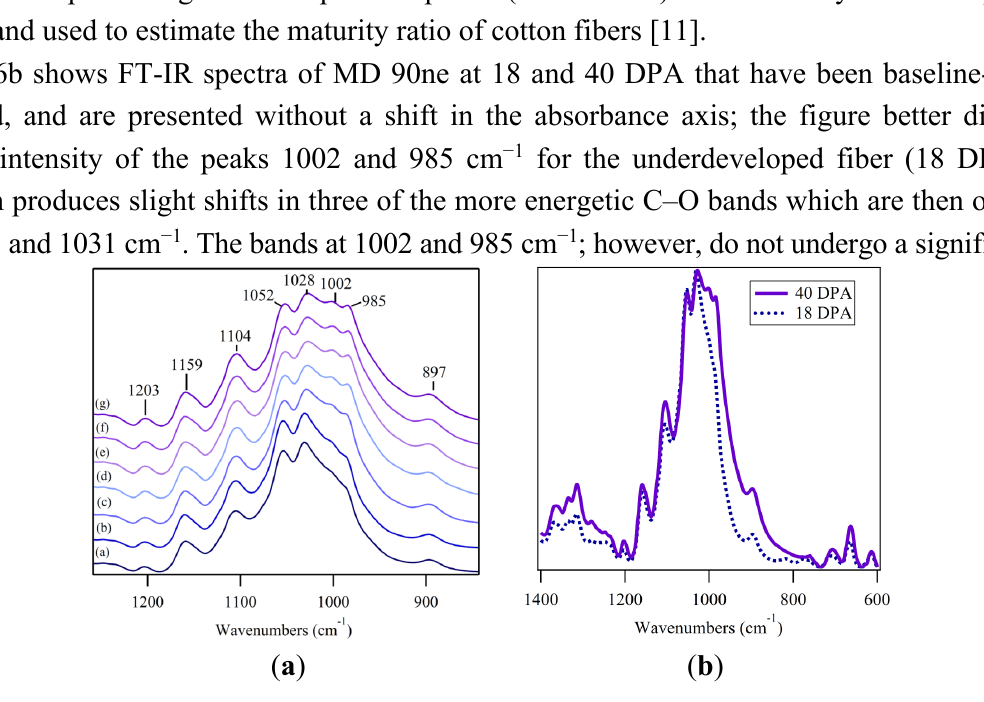
Figure 6. ( a ) FTIR spectra of the C–O stretching region for cotton fibers harvested at different DPA: (a) 18 DPA; (b) 20 DPA; (c) 24 DPA; (d) 28 DPA; (e) 32 DPA; (f) 36 DPA; and (g) 40 DPA; ( b ) spectra for fibers harvested at 18 DPA and 40 DPA, shown without